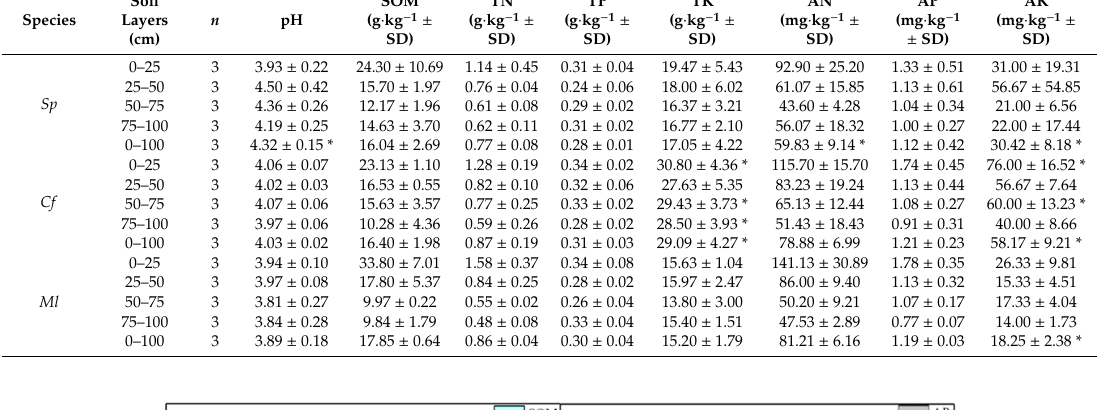
0–25, 25–50, 50–75, 75–100 and 0–100 cm layers. The symbol ‘*’ indicates significant di ff erences ( p < 0.05) between di ff erent tree species in same layers.